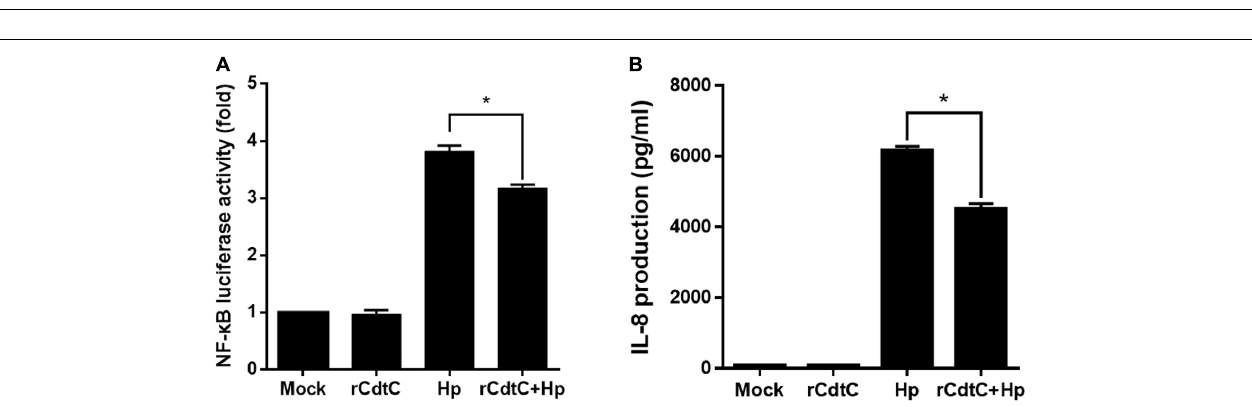
FIGURE 4 | rCdtC decreases CagA translocation in Helicobacter pylori -infected cells. (A) AGS cells pre-incubated with rCdtC (200 nM) were infected with or without CagA-EGFP H. pylori (green) at a multiplicity of infection of 20 for 2 h. The cells were probed with anti-CdtC (yellow), the plasma membrane was stained with WGA-conjugated Alexa Flour 594 (red), and the nuclei were stained with Hoechst 33342 (blue). Arrows indicate CagA translocated into the cytoplasm. The image was analyzed by a confocal microscope with 63 × oil immersion objective and processed by software ZEN. Scale bar, 10 µ m. (B) CagA-EGFP translocation was quantified by green fluorescence intensity. Green puncta representing CagA that existed in the bacteria were excluded from the fluorescence intensity analysis. The quantification indicated the mean pixel intensity of the CagA signal in the cytoplasm of each cell (50 cells were analyzed per sample). * P < 0.05. (C) The level of CagA translocation was determined by using western blot assay. β -Actin expression was used to represent an internal control for equal loading.